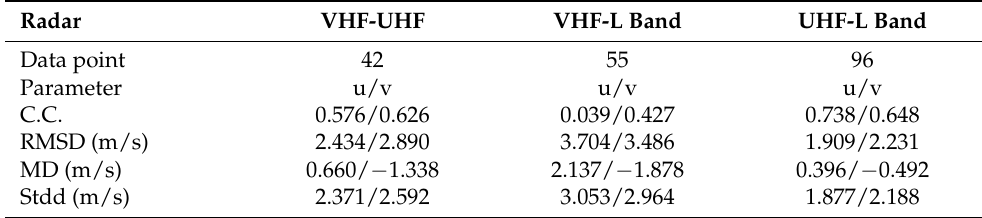
Figure 11. Examples of Doppler spectra observed by obliquely pointed radar beam of the 52 MHz VHF radar in precipitation environment, in which spectral components of clear air echoes, raindrop echoes, and mixed echoes, which are the combination of echoes from raindrops, water droplets, and clear air turbulence, are marked. Table 6. Comparisons of zonal wind (u) and meridional wind velocity (v) between wind profilers in the presence of